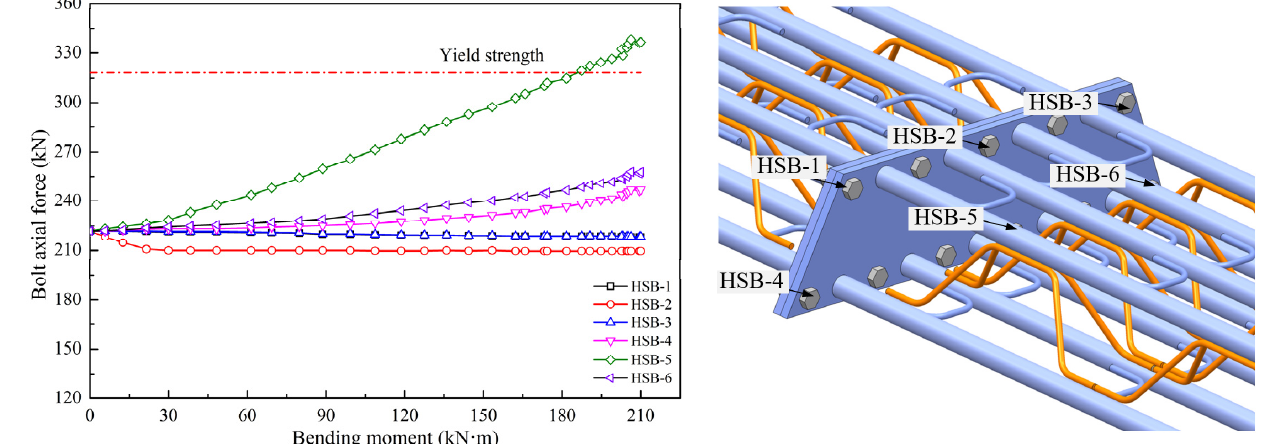
Figure 15. Bending moment–axial force of the bolts relationship curves of the end-plate joint component. By analyzing the force of the bolts at different positions, it can be seen that the lower bolts bear a greater tensile load than the upper bolts. Among them, the axial force of the HSB-5 bolt at the limit state is 48.0% higher than the final pretightening force, which exceeds the yield strength by 3.3%. The axial force of the HSB-4 bolt and HSB-6 bolt are increased by 9.3% and 14.0%, compared to the final pretightening force, respectively. However, the axial force of the upper bolts is decreased